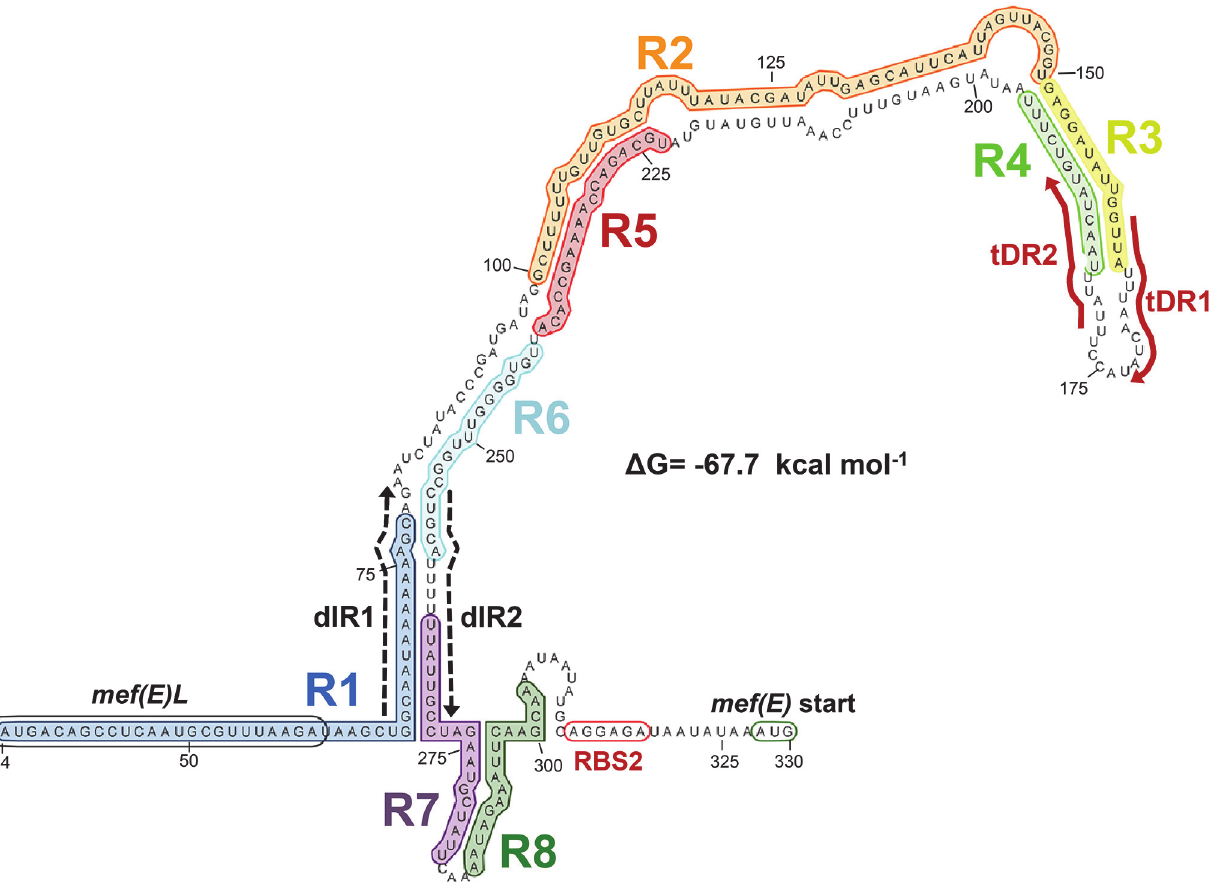
Fig 4. Structure of the mef(E)/mel 5 0 anti-attenuator structure (transcriptionally active). Structure generated by RNAFold of the 249 bases remaining after removing of the 64 nucleotides from the 5 0 terminus predicted to be unavailable for base paring due to macrolide-induced ribosomal stalling. Annotations are the same as stated for Fig.